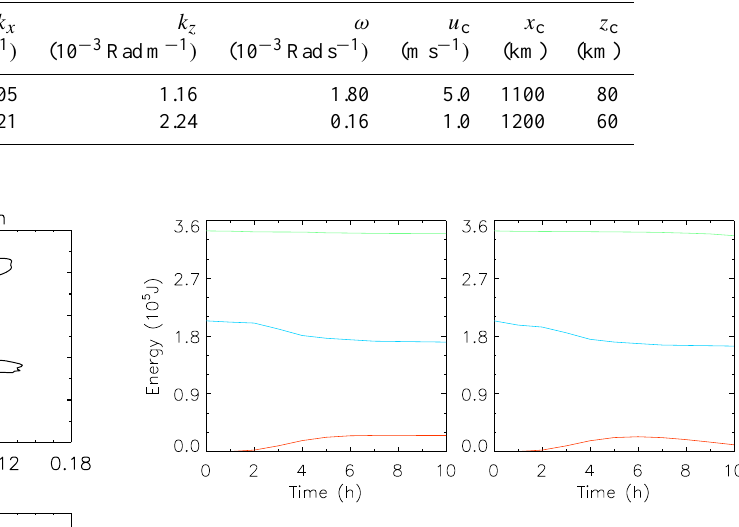
Fig. 10. Evolution of wave energies in propagation and interaction for cases 3 (left) and 4 (right). The cyan, green and red lines denote the energies of waves 1–3,